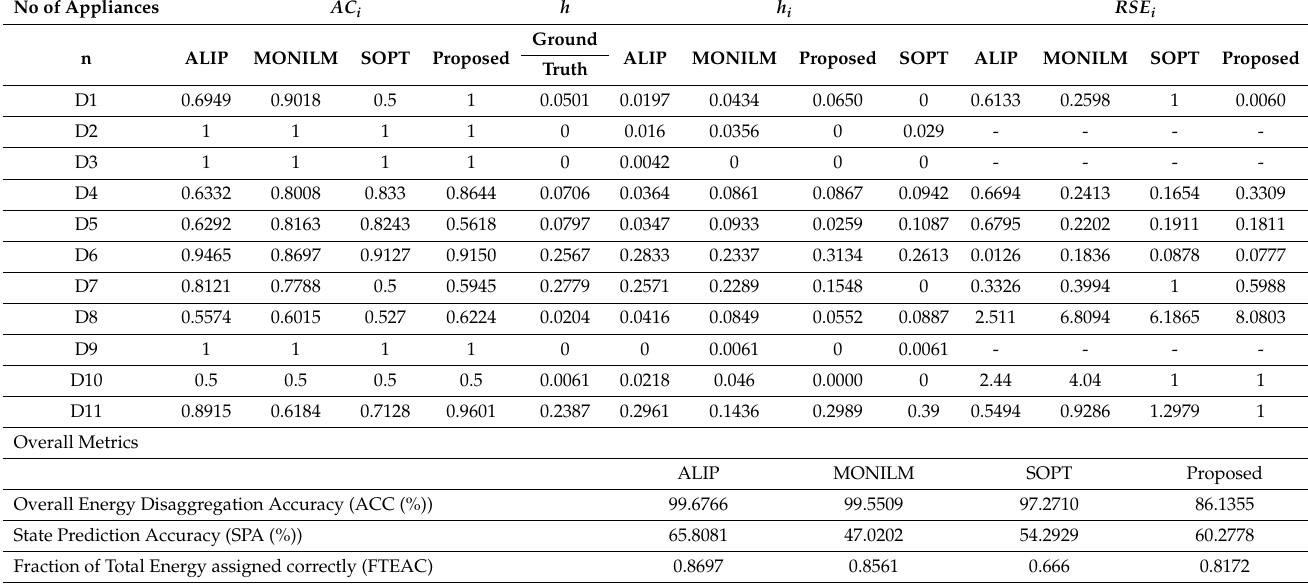
Table 6. Comparison of the proposed framework with state-of-the-art methods in terms of energy disaggregation in the I 12 problem